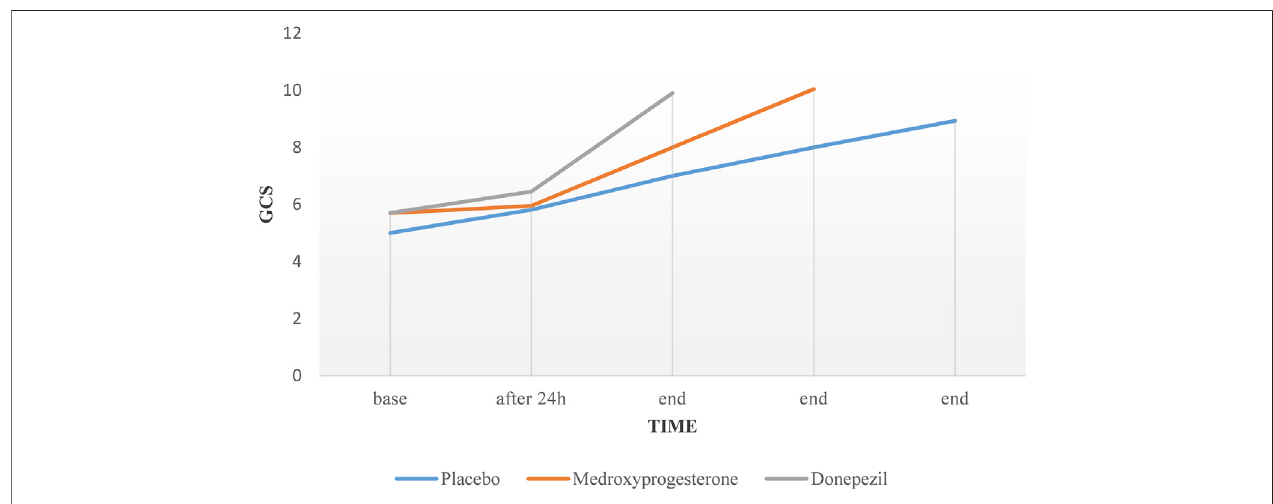
FIGURE 2 | Mean variations of GCS in three different groups over the